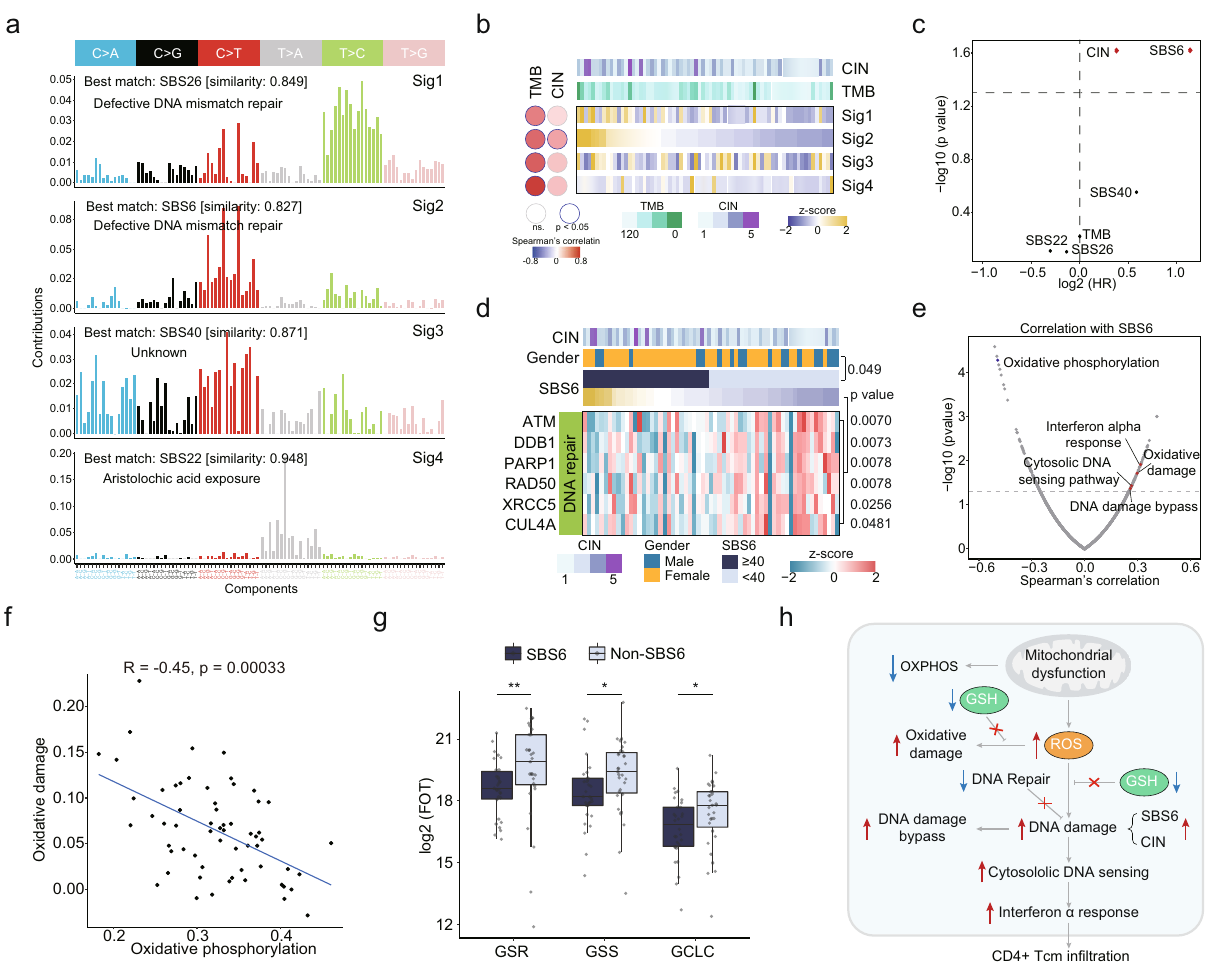
Fig. 3 | Identi fi cation of mutational signatures and associated signaling path- ways. a Decomposition of four mutational signatures from the tRCC cohort. b Correlations between mutational signatures and TMB and CIN. c Cox regression analysisof TMB, CIN, and mutational signatures. d Heatmap showing differentially expressed DNA repair molecules between tRCC with and without SBS6 (two-sided Wilcoxon rank-sum test). e Scatter plot showing the correlation of SBS6 and Wikipathway ssGSEA scores. f Wikipathways oxidative damage and oxidative phosphorylationshowsastrongnegativecorrelation. g Relativeproteinabundance